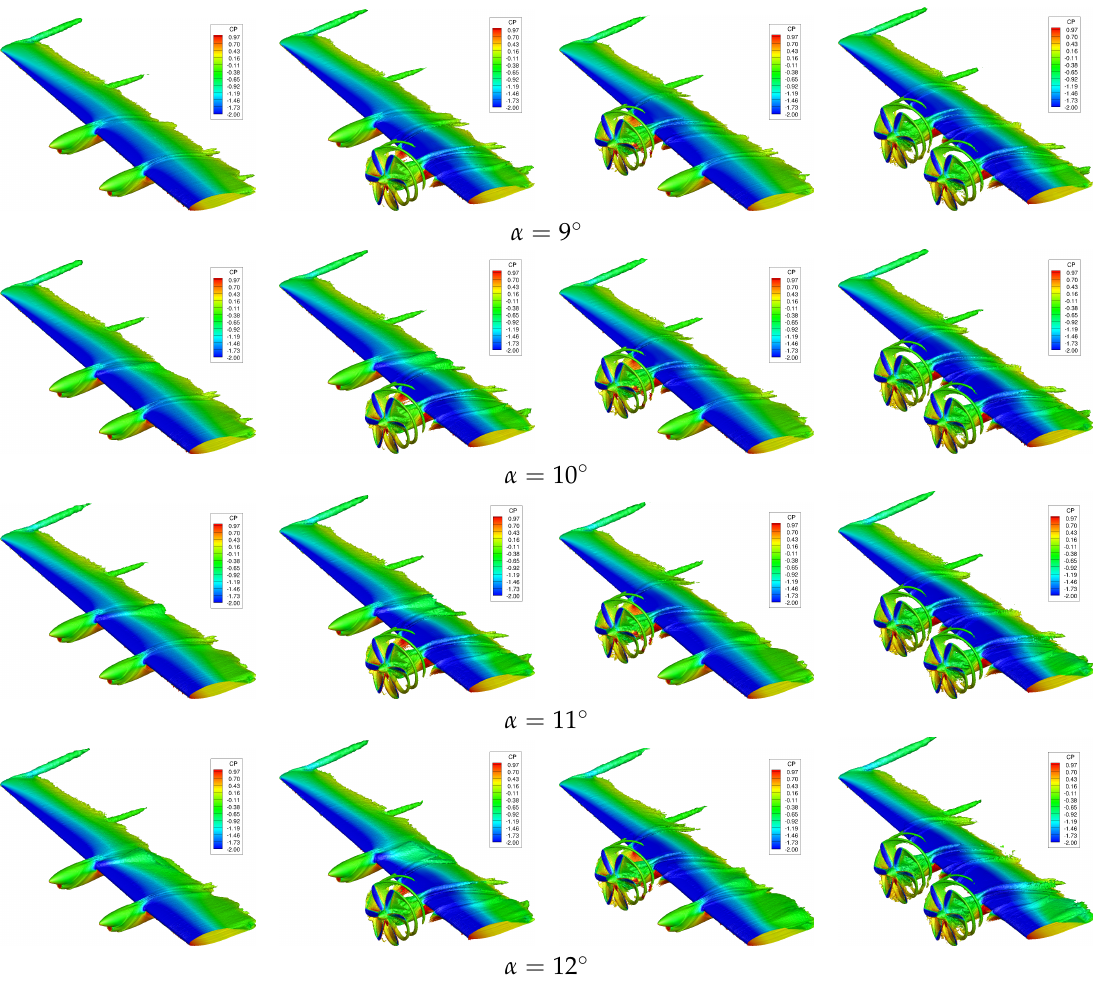
Figure 15. Propeller installed inboard/outboard; it has a 20-deg blade angle. Wing solution is time-averaged. Wing+Prop solutions are at a time of six